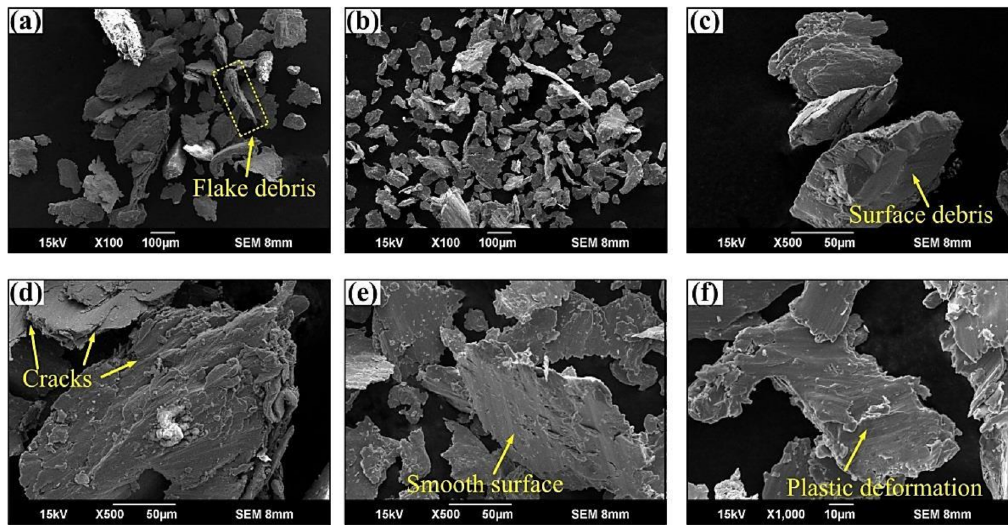
Figure 11. Scanning electron microscopy (SEM) micrographs of the wear debris with different magnifications. ( a , d ) × 100; ( c – e ) × 500; ( f ) ×